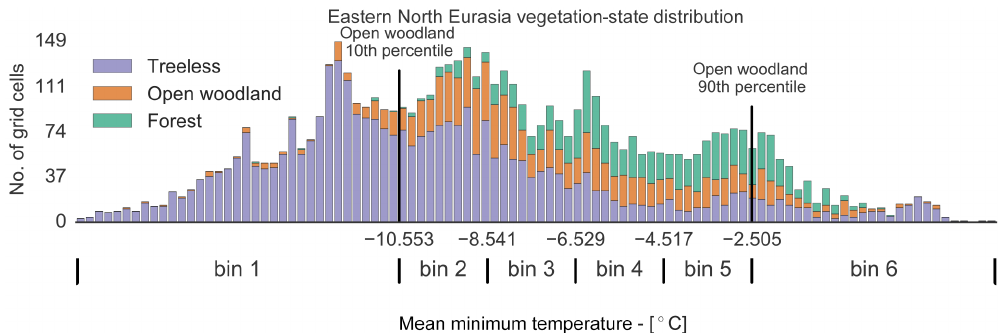
Figure 1. Bin division of mean minimum temperature for eastern North Eurasia. The boundaries of the first and last bins are calculated using the second-lowest 10th percentile and second-highest 90th percentile of the three vegetation states, with respect to the environmental variable in use, having in mind that only one vegetation state is generally found below or above these thresholds, respectively. The remaining space is subdivided uniformly.